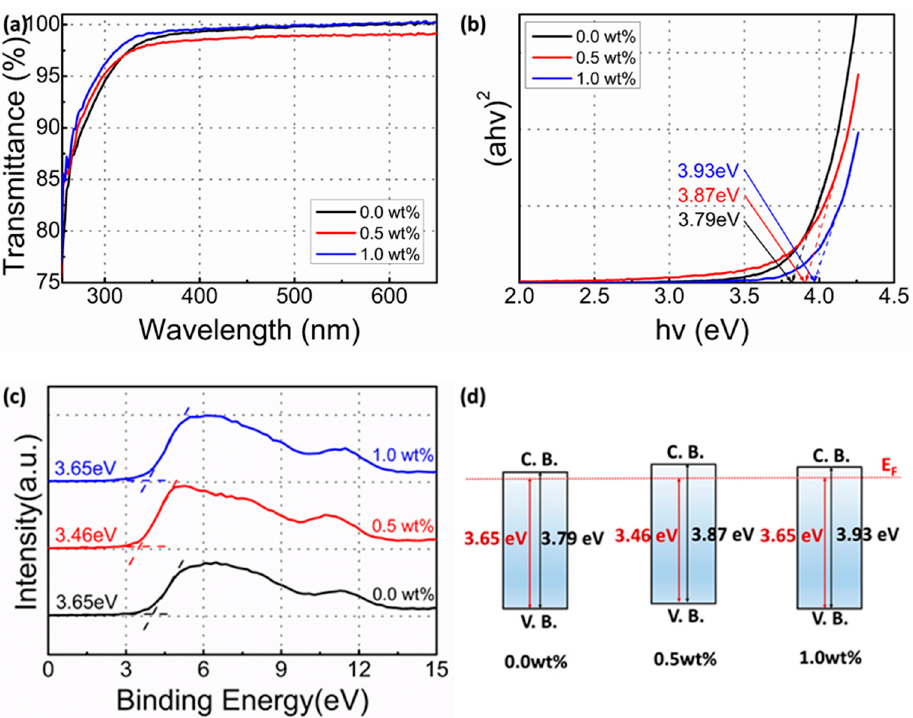
Figure 3. ( a ) Transmittance spectra of Li-doped SnO 2 films as a function of Li (wt%). ( b ) Optical bandgap of Li-doped SnO 2 films as a function of Li (wt%). ( c ) VB offset based on XPS spectra. ( d ) Schematic energy band based on the Fermi energy-level position.